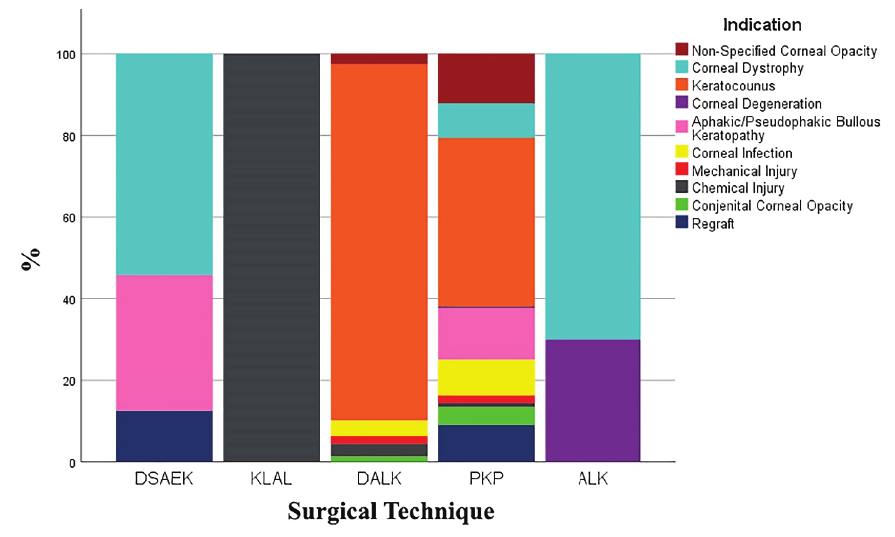
Figure 4. The proportion of indications for each surgical procedure. Keratoconus was the leading indication for PKP (41.3%) and DALK (87.4%), while corneal dystrophies were the main cause for DSAEK (54.2%) and ALK (70%). KLAL technique was exclusively used for chemical injuries (100%). PKP, penetrating keratoplasty; DALK, deep anterior lamellar keratoplasty; DSAEK, Descemet stripping automated endothelial keratoplasty; ALK, anterior lamellar keratoplasty; KLAL, keratolimbal